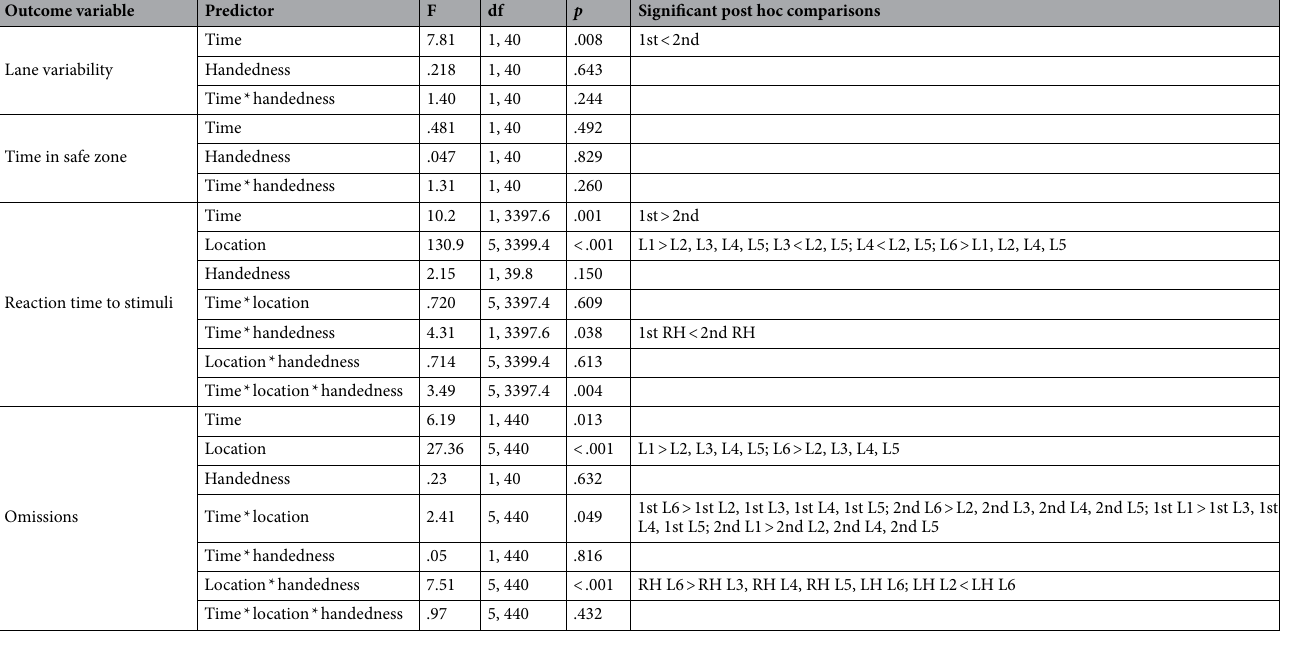
Table 2. F values, degrees of freedom, p values and holm corrected post hoc comparisons with corrections relative to time-on-task and handedness, for driving simulator variables derived from the mixed effects models. Location is an additional predictor in the reaction time and omissions to peripheral stimuli models. LH = left-handers, RH = right-handers. For post hoc analyses < and > indicate the direction of the effect (e.g., LH 1st < LH 2nd refers to left-handers’ performance in the first half of the drive is lower than that of left- handers’ performance in the second half of drive). L1 = location 1, L2, location 2, L3 = location 3, L4 = location 4, L5 = location 5, L6 = location 6. Only relevant post hoc comparisons reaching statistical significance ( p < .05) following corrections for multiple comparisons are reported for